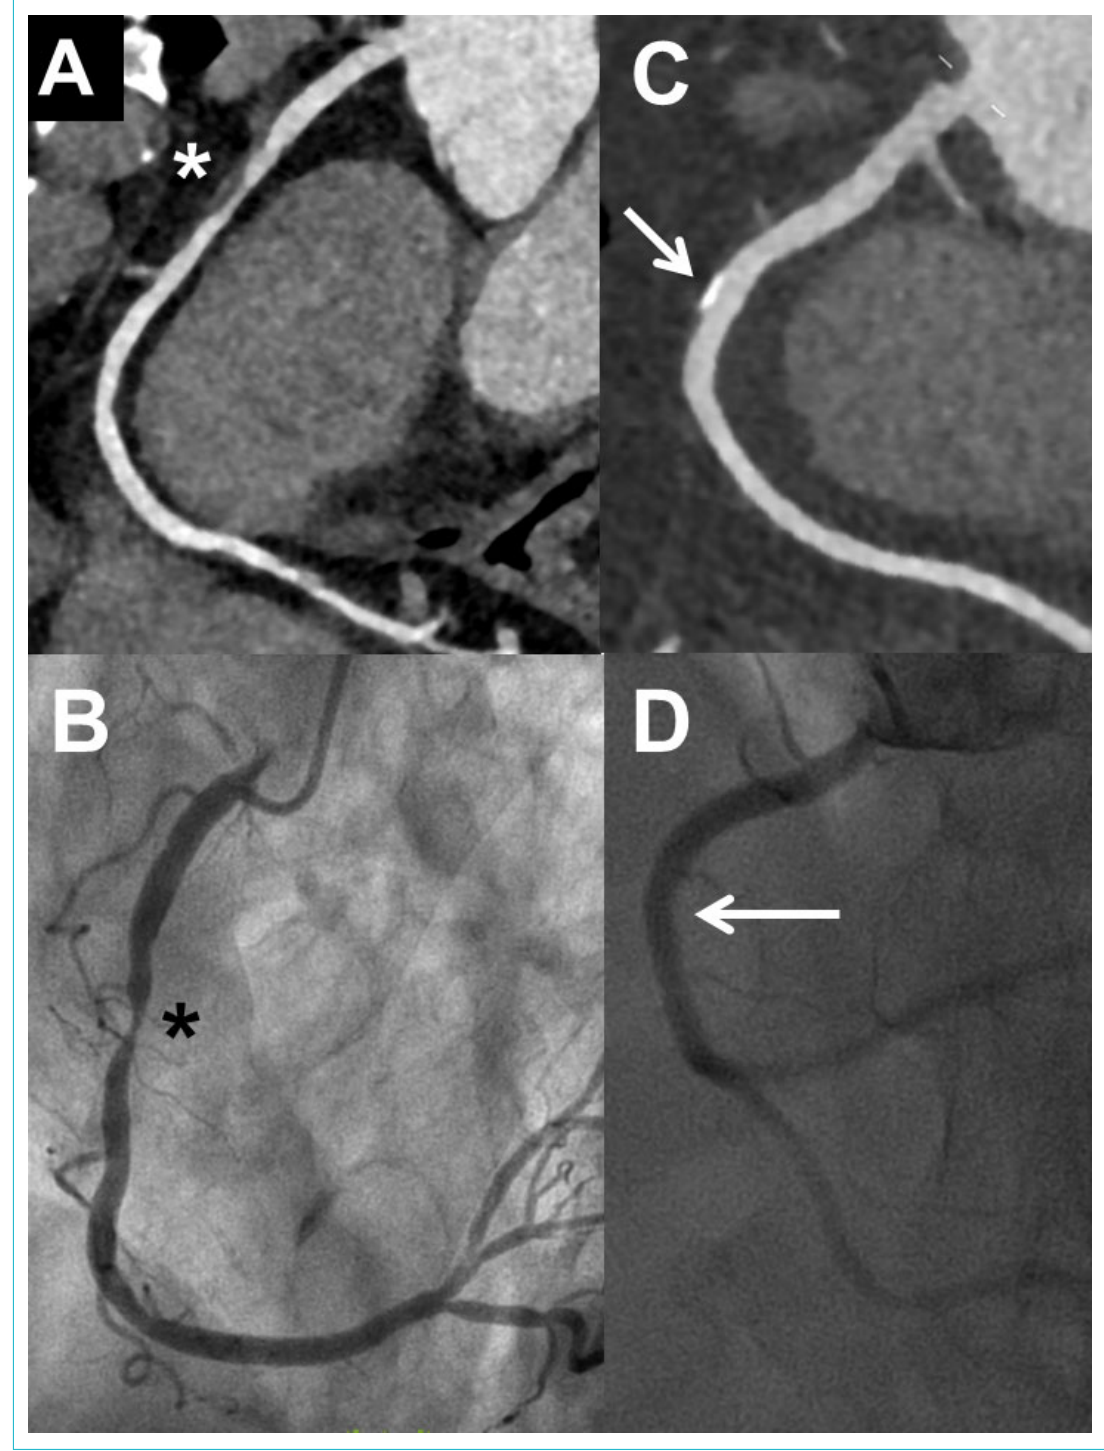
Figure 2: Examples of coronary computed tomography (CCTA) and invasive coronary angiography (ICA) in two patients with excellent corre- lation of the two methods: First patient (male, 62 years) with severe stenosis in the mid right coronary artery in CCTA (panel A, asterisk) and ICA (panel B, asterisk). Second patient (male, 58 years) with plaque (no relevant stenosis) in the mid right coronary artery in CCTA (panel C, arrow) and ICA (panel D,